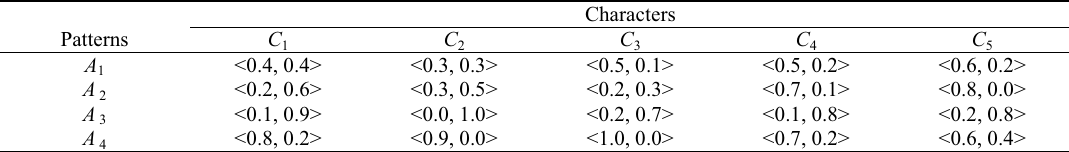
Table 5. Character sets of the patterns.